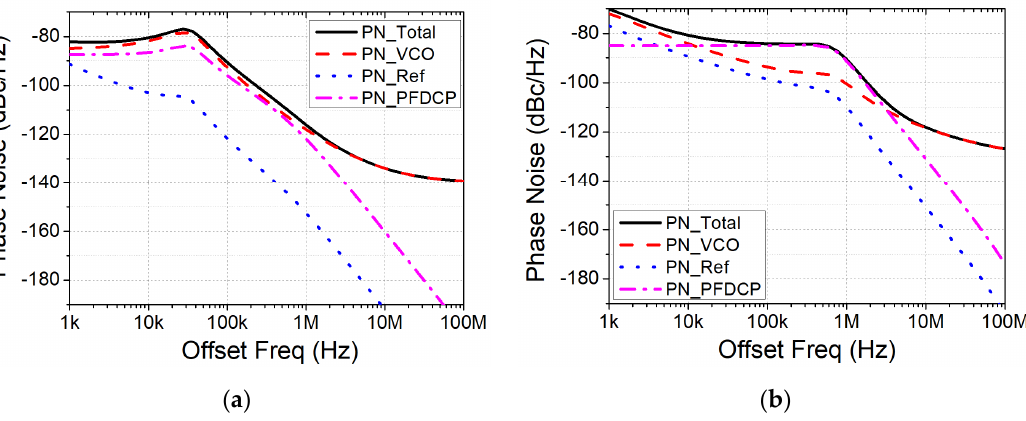
Figure 7. Simulated phase noise contributions at ( a ) the Output1 from Loop1; ( b ) the Output2 from Loop2 with doubler.